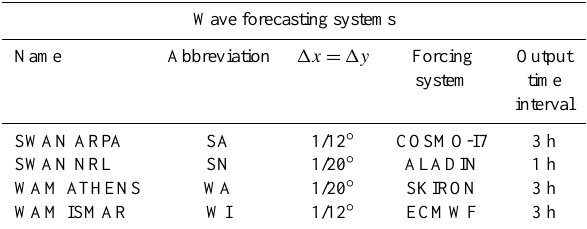
Table 1. Main specificities of the forecasting